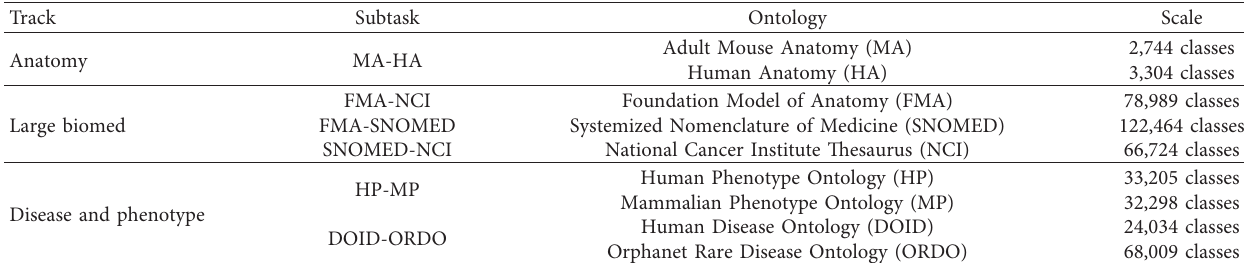
Table 1: Description on the OAEI’s